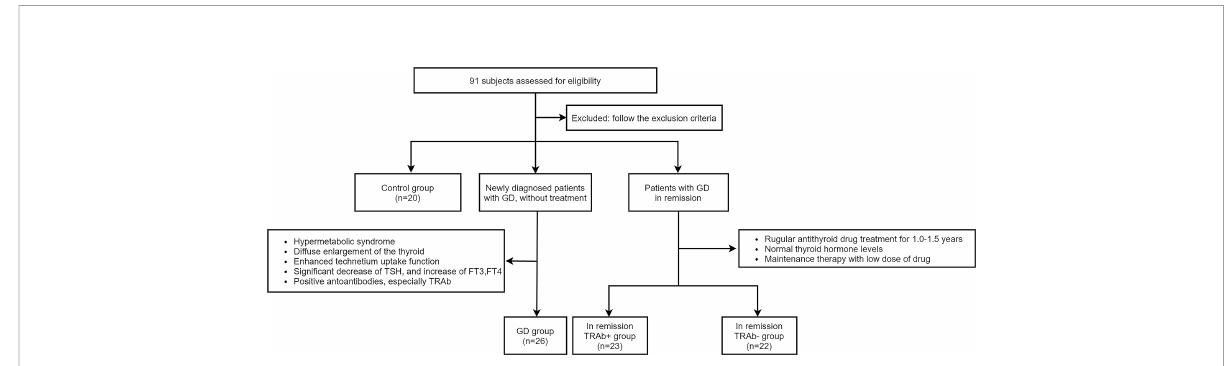
FIGURE 1 According to the inclusion and exclusion criteria, four groups were established in the experiment: Control group, Graves ’ disease (GD) group, and in remission thyroid-stimulating hormone receptor antibody (TRAb + and TRAb − )